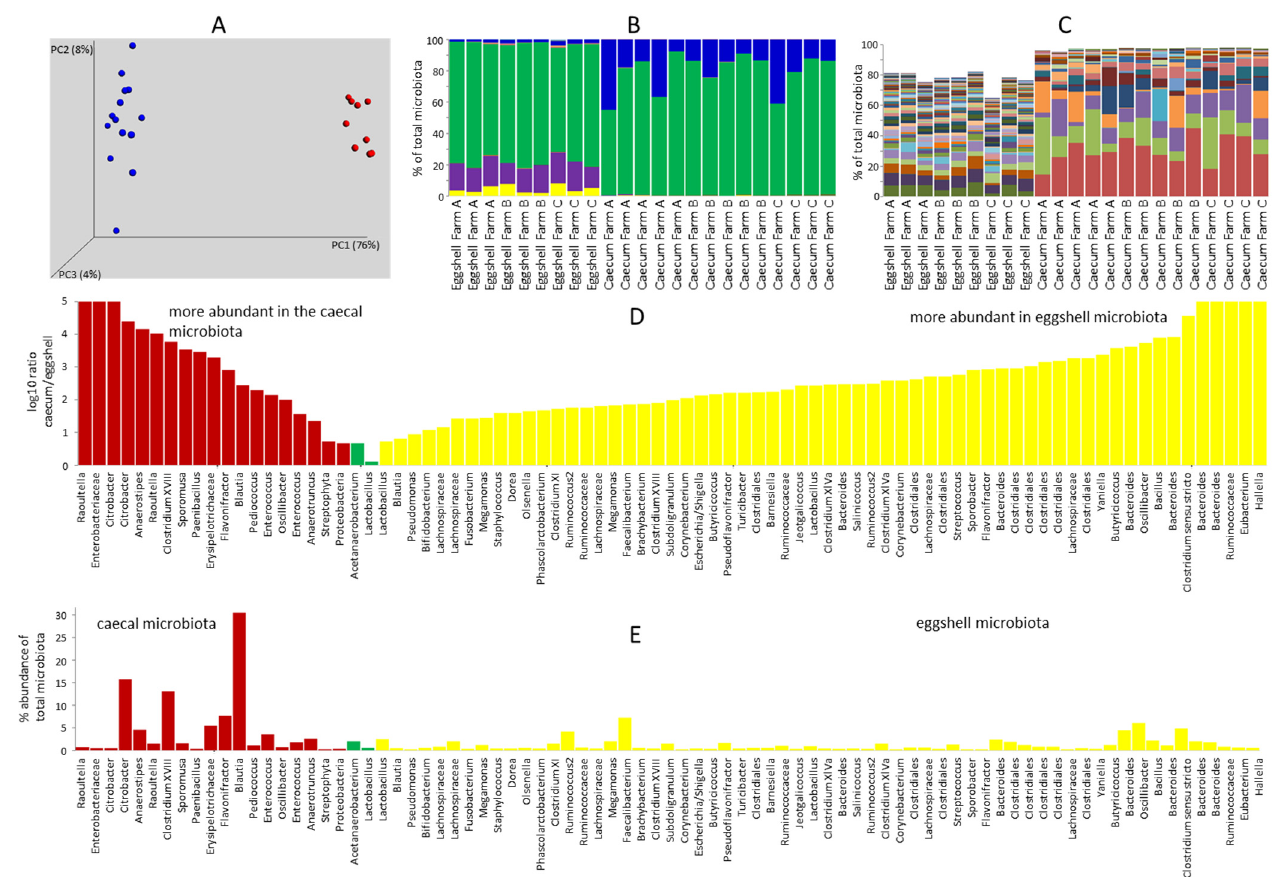
Figure 1. Comparison of eggshell microbiota and caecal microbiota of one-week old chicks. ( A ), weighted Principal Coordinate Analysis (PCoA) of caecal microbiota of one-week-old chickens (blue dots) and microbiota of eggshells (red dots). ( B ), microbiota composition of individual caecal and eggshell samples at phylum level (blue—Proteobacteria, green— Firmicutes, magenta—Bacteroidetes, yellow—Actinobacteria). Microbiota of eggshells resembled caecal microbiota of adult hens due to the presence of Bacteroidetes and Actinobacteria and low representation of Proteobacteria. ( C ), individual samples at OTU level (top 100 OTUs were used for figure generation) showing completely different composition of caecal microbiota of one-week-old chickens and eggshells microbiota before incubation (see Table S1 for OTU composition). ( D ), absolute values of log 10 ratios of abundances of OTUs forming more than 0.3% of total microbiota, either in the caecum or in eggshells. Since the biological meaning of the ratios in ( D ) is influenced also by abundance in of each microbiota member, either in the caecal or eggshell microbiota, these are shown in ( E ). Abundance in caecal microbiota is shown for the OTUs more abundant in the caecum, and vice versa, abundance in eggshell microbiota is shown for the OTUs more abundant in eggshell microbiota.